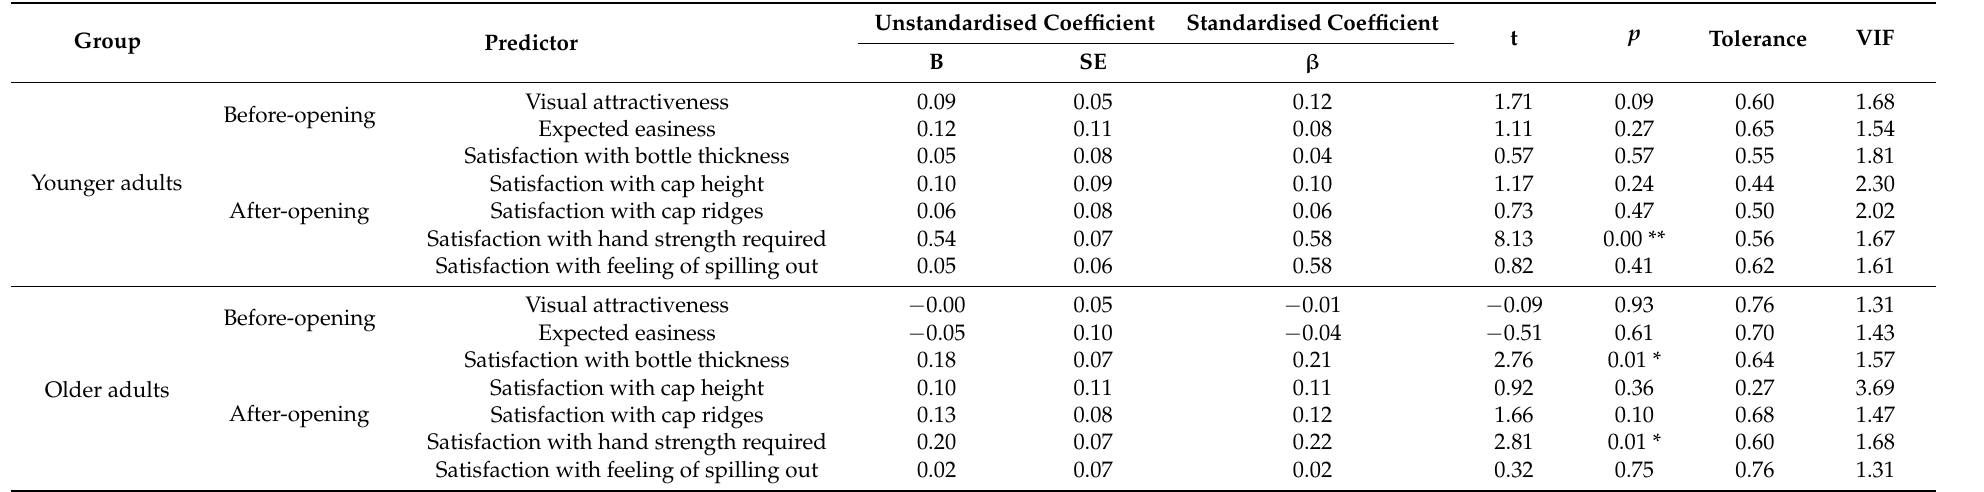
Table 6. Results of the regression analysis and * indicated the significant levels (* < 0.05, ** < 0.001).